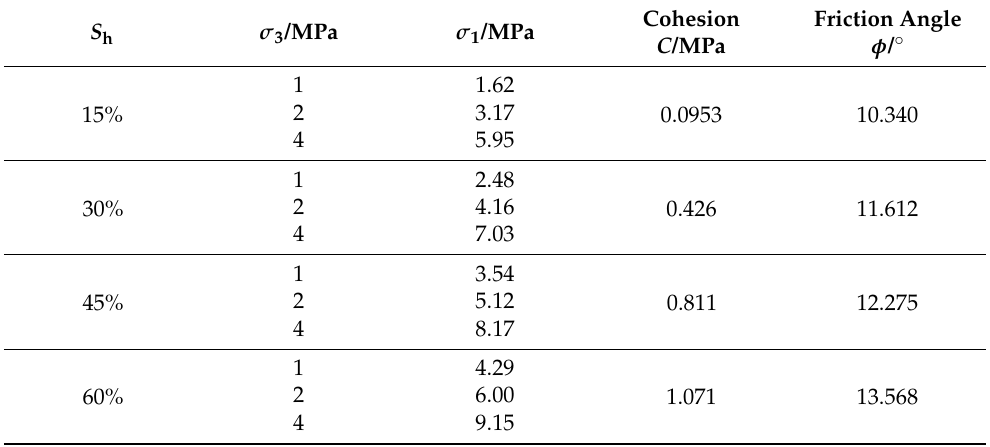
Table 1. Mechanical parameters of the